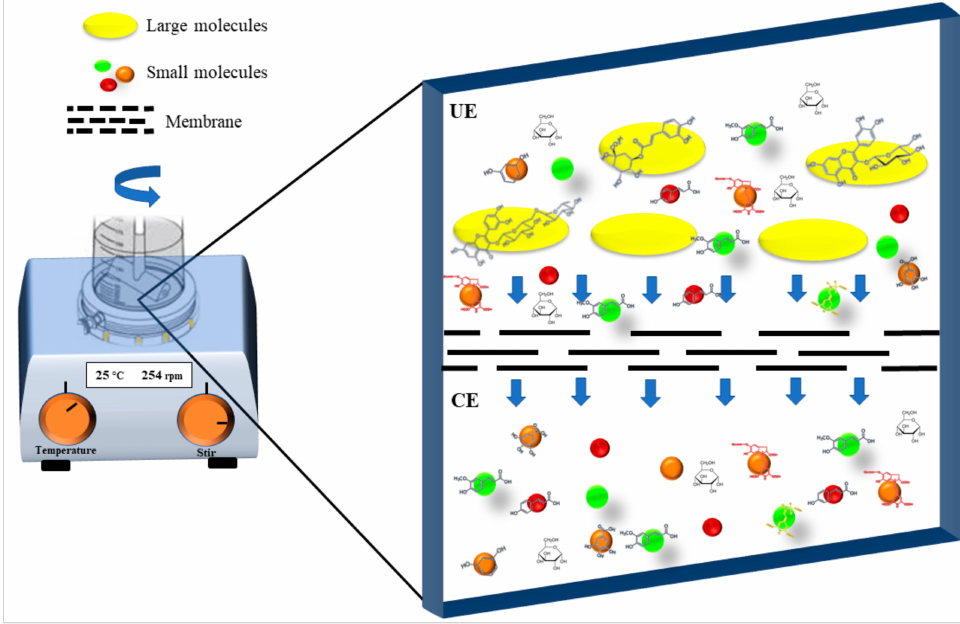
Figure 4. Scheme of the ultrafiltration process representing the main molecules present in the pitaya extract ( Stenocereus thurberi ) before and after the